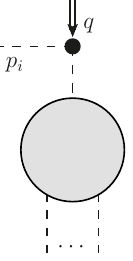
· · · ) . This apparently requires terms in ˜ J that are i · q